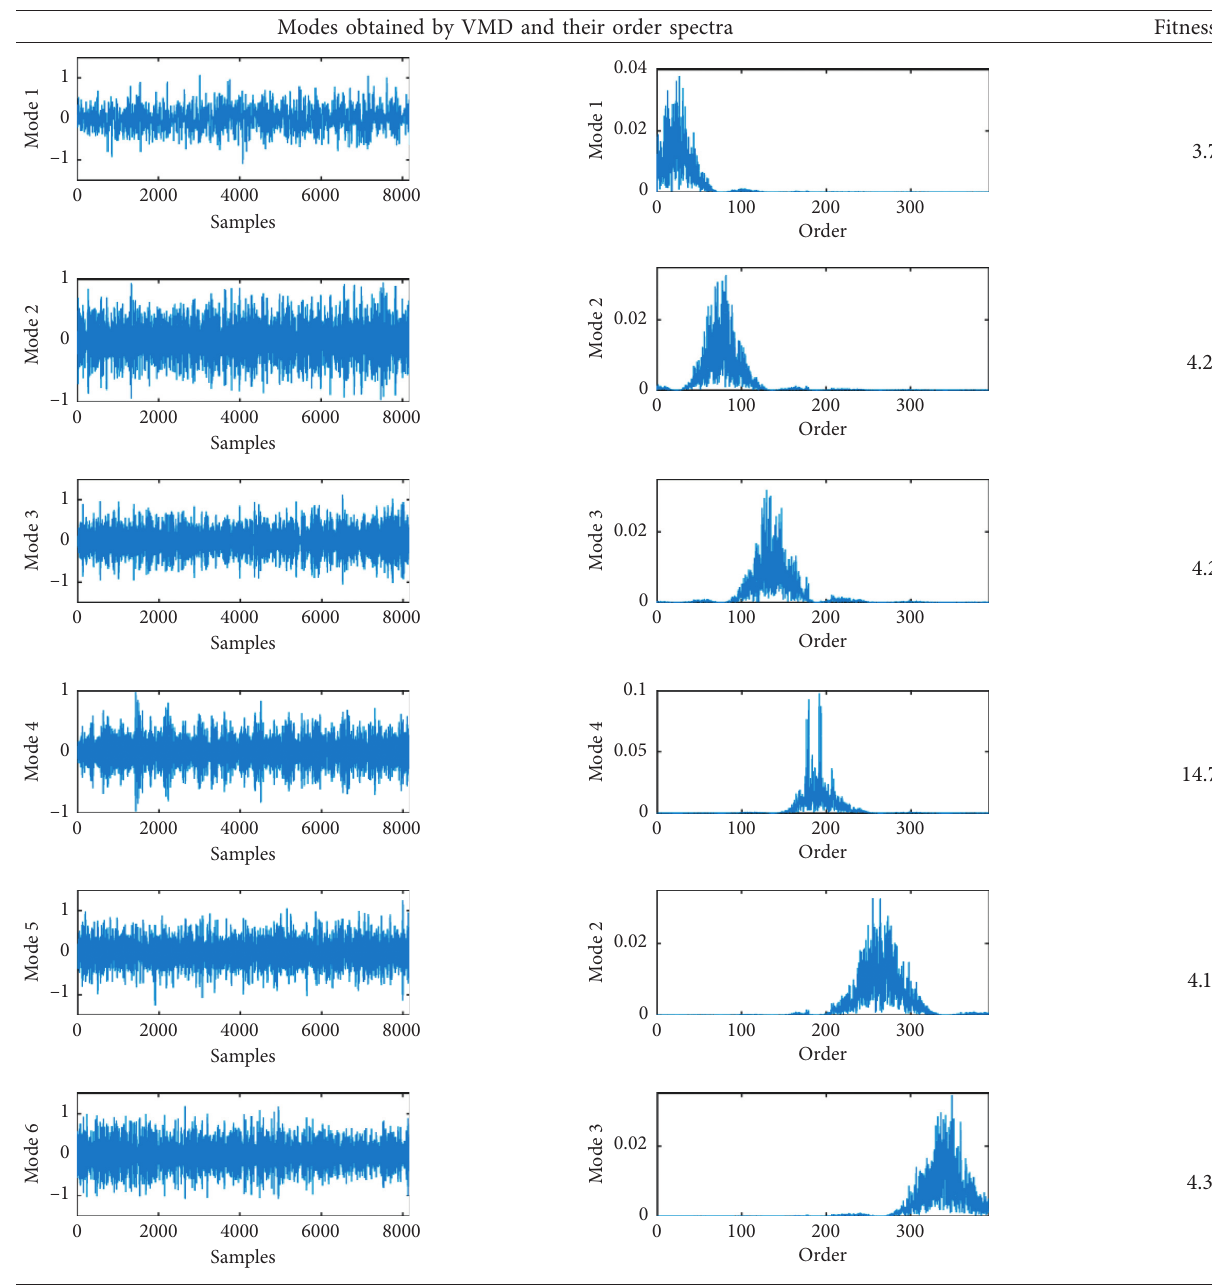
Table 2: Fitness values obtained by analyzing simulation signal with VMD. Modes obtained by VMD and their order